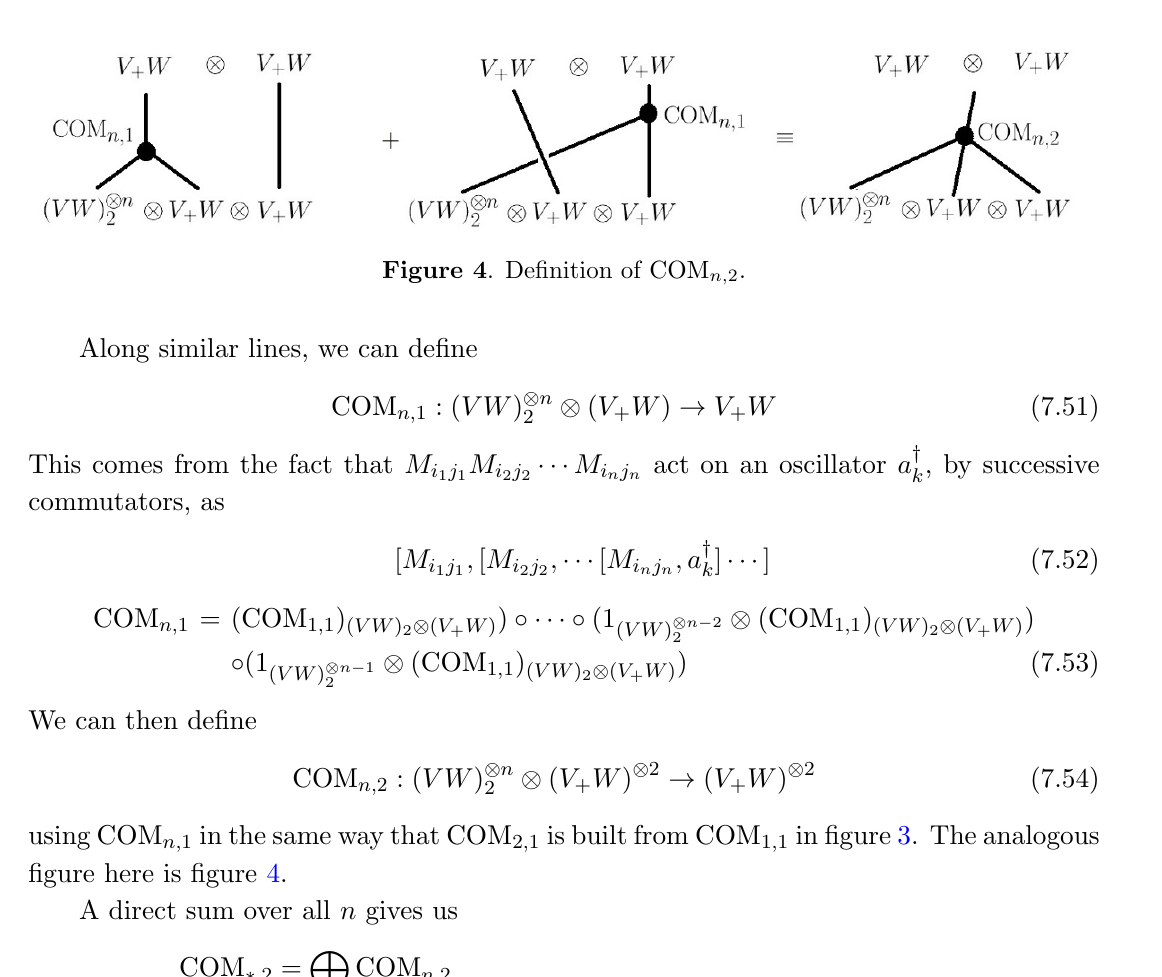
Figure 3 . De(cid:12)nition of COM 1 ; 2 .